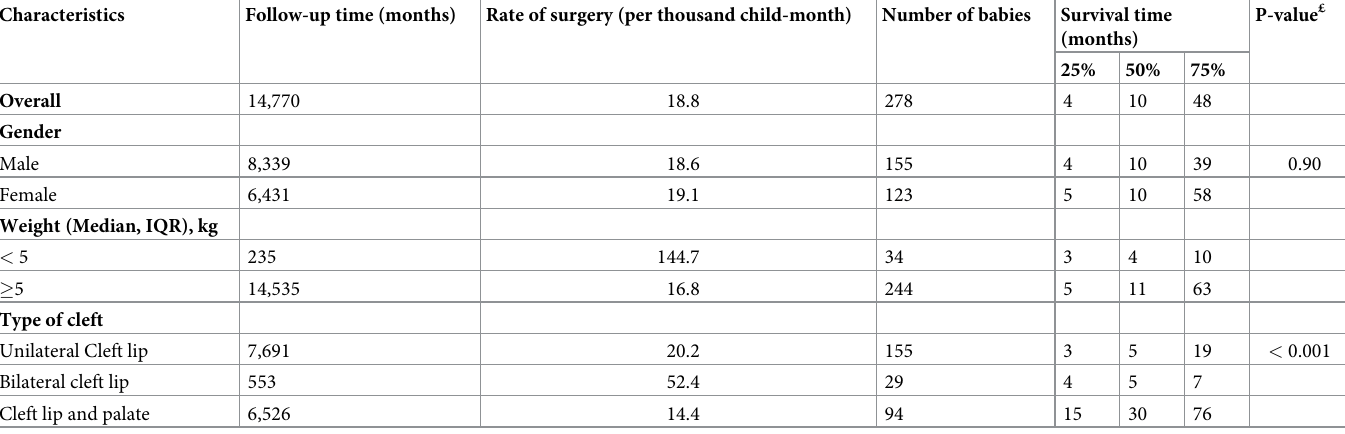
Table 4. Association between survival time and gender and type of primary surgery. Characteristics